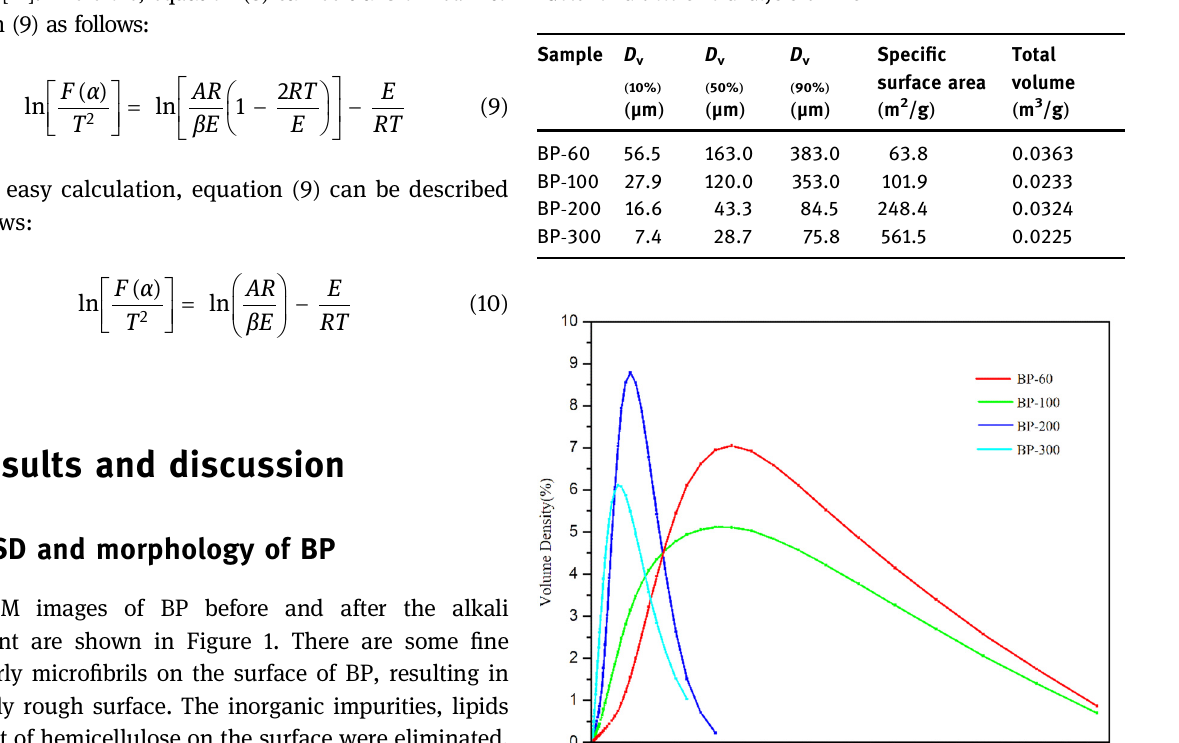
Table 1: Particle size analysis of BPs